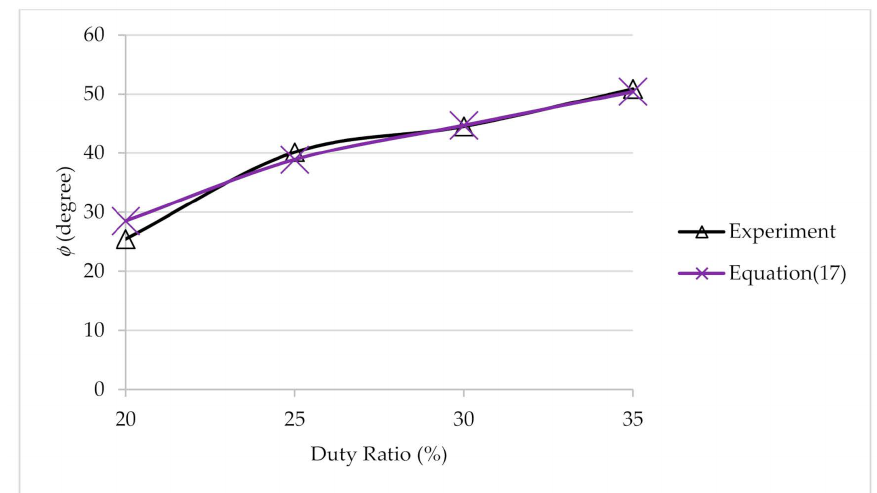
Figure 12. Comparison between experimental values and those obtained using Equation (17).